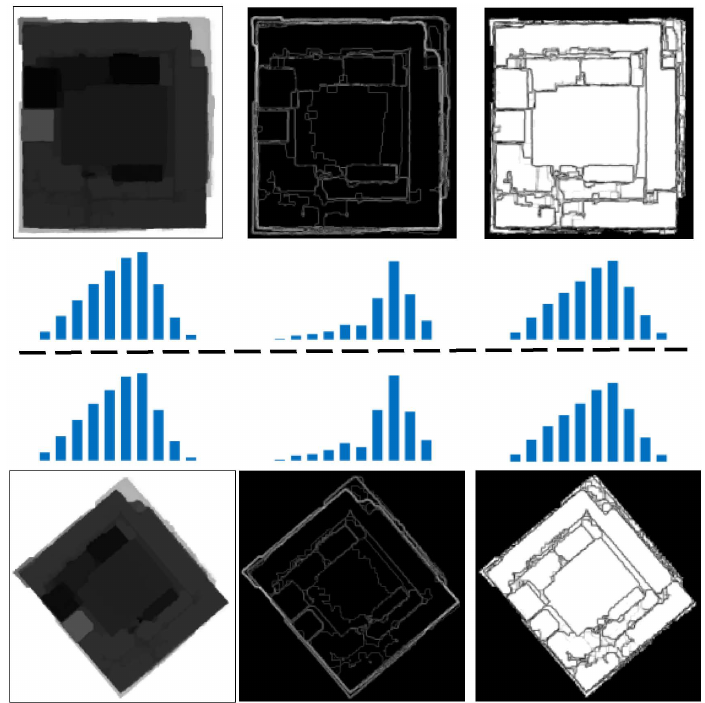
Figure 8. Demonstration of rotation invariance. ( Top ): results of geometric features and corresponding spatial histograms; ( Bottom ): results of rotated data (45-degree rotation).